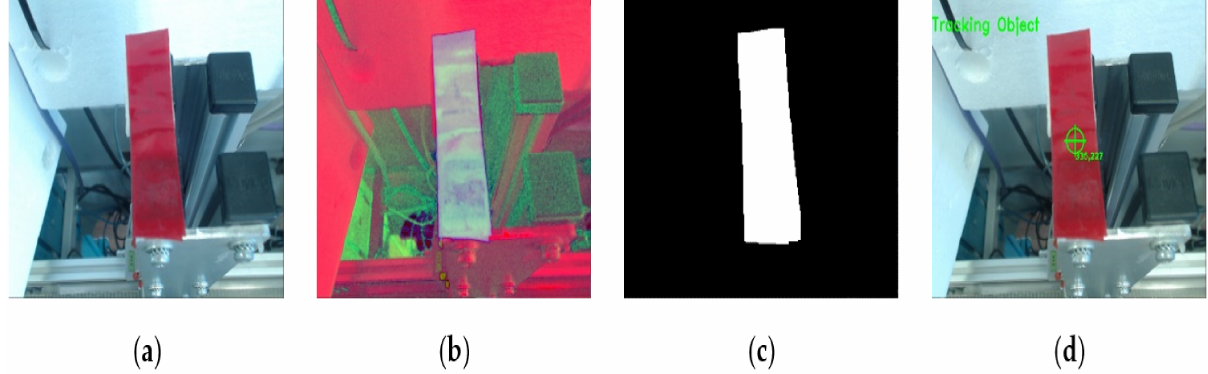
Figure 22. Warehouse reference color detection: ( a ) raw RGB image, ( b ) BGR to HSV conversion, ( c ) HSV limits are imposed and the result is shown as a white blob with a black background, ( d ) the reference color is detected, and the centroid is